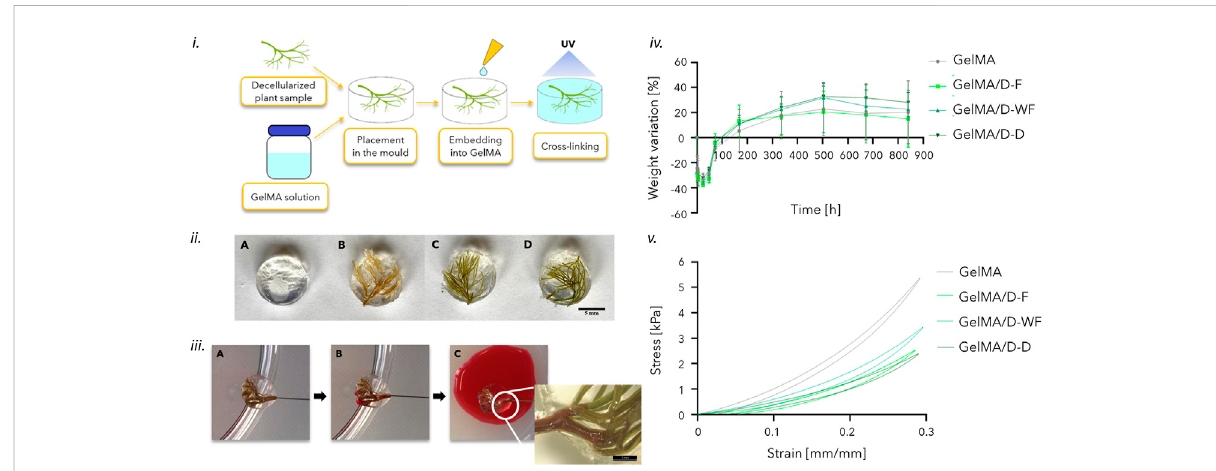
FIGURE 2 i) Scheme of the process to obtain the 3D scaffold-based model: insertion of the decellularized leaf (D-leaf) in the PDMS mold, dripping of the GelMAsolutionandUVlightcrosslinking. ii) SamplesaftertheGelMAphotocrosslinking:(A)GelMA,(B)GelMA/D-F, (C)GelMA/D-WF,and(D)GelMA/ D-D; scale bar: 5 mm iii) Perfusion test on GelMA/D-F structures by injection of red dye: A) before the injection; B) after the complete fi lling of the hollowchannel;aparticularoftheperfusedstructure:reddyeisvisibleinthedecellularizedchannelsoftheleafbranches. iv) Percentageweight variation curves of GelMA/D-leaf structures and GelMA samples. v) Representative stress-strain curves of GelMA/D-leaf structures and GelMA, obtained by mechanical compression